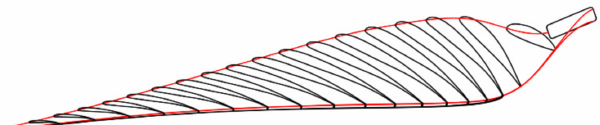
Figure 12. Parametric method for the propeller with a Gurney